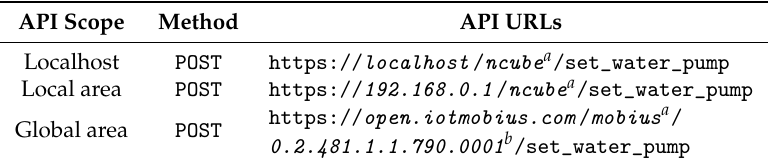
Table 2. Given a thing adaptation software (TAS) function (i.e., set_water_pump ), for the water pump in Planty, a comparison of corresponding REST API URLs for controlling it: in localhost, in a local area network, and in a global area